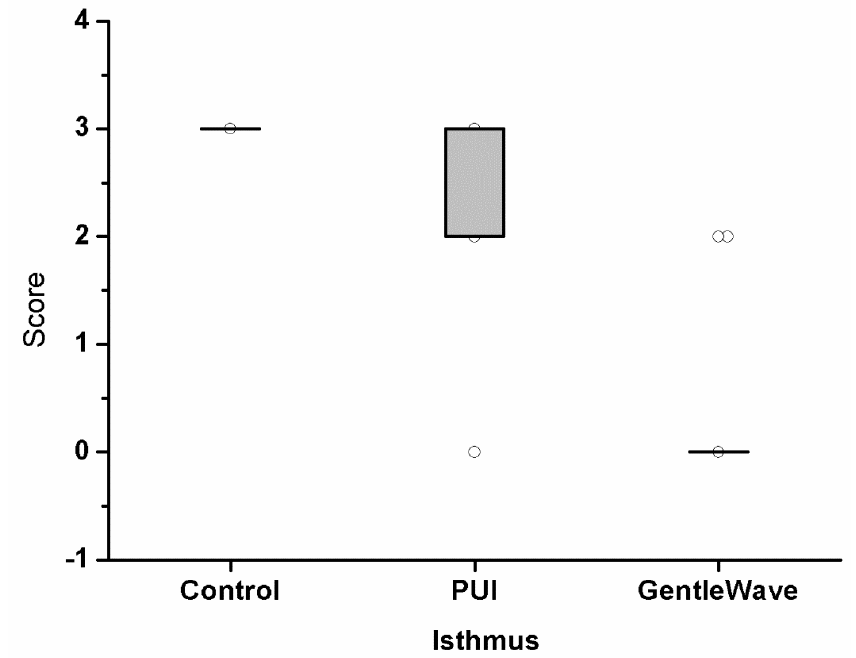
Figure 4. The level of biofilm attachment scores from three independent evaluators for 39 molars in the isthmus region. The samples were either untreated (Group 1), treated with passive ultrasonic activation system (Group 2), or treated with the GentleWave system (Group 3). The modified scores utilized were—Score 0: no bacteria; Score 1: sparse and detached bacteria; Score 2: well defined biofilm (small colonies, <50% of the canal wall covered); and Score 3: well defined biofilm (large colonies, >50% of the canal wall covered). The average scores analyzed for the canals between Group 2 and Group 3 were statistically different (p < 0.001).